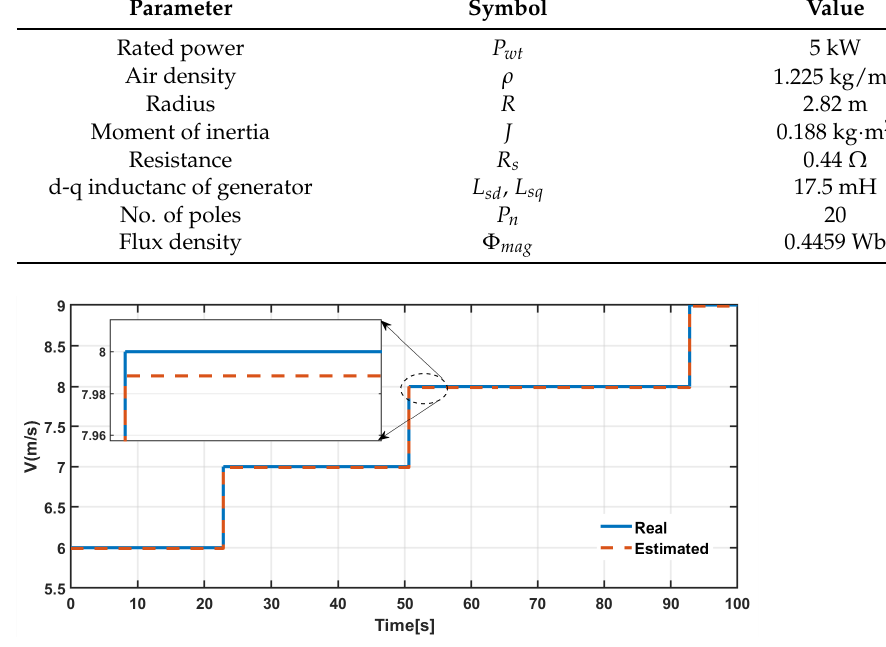
Figure 8. Real and estimated wind